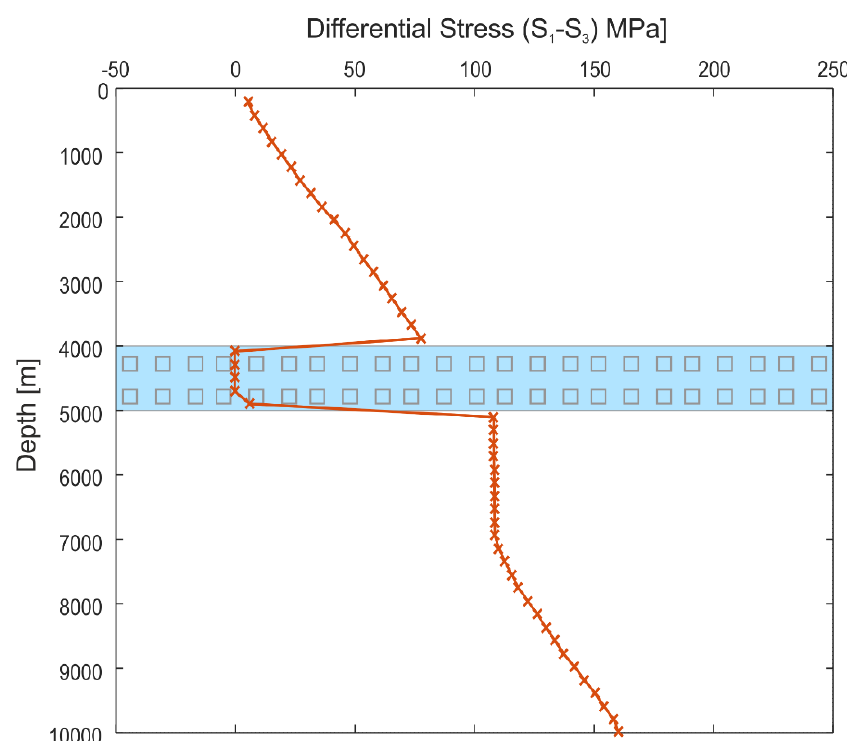
Figure 4. Differential stress (S 1 –S 3 ) for a model with a salt viscosity of 10 18 Pa · s (Model A-02) along a vertical path through the centre of the model (equivalent to a hypothetical well; see W1 in Figure 2c). The blue layer marks the depth interval of the salt. Within the salt layer, differential stresses essentially vanish.